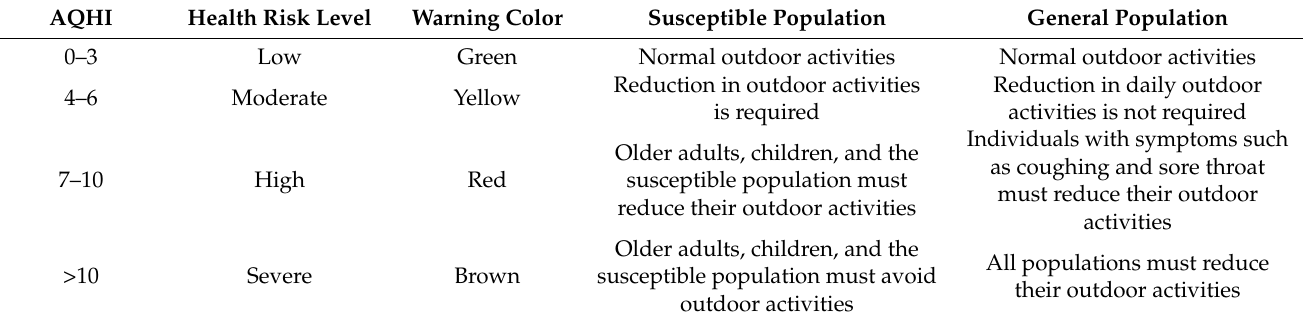
Table 3. AQHI classification